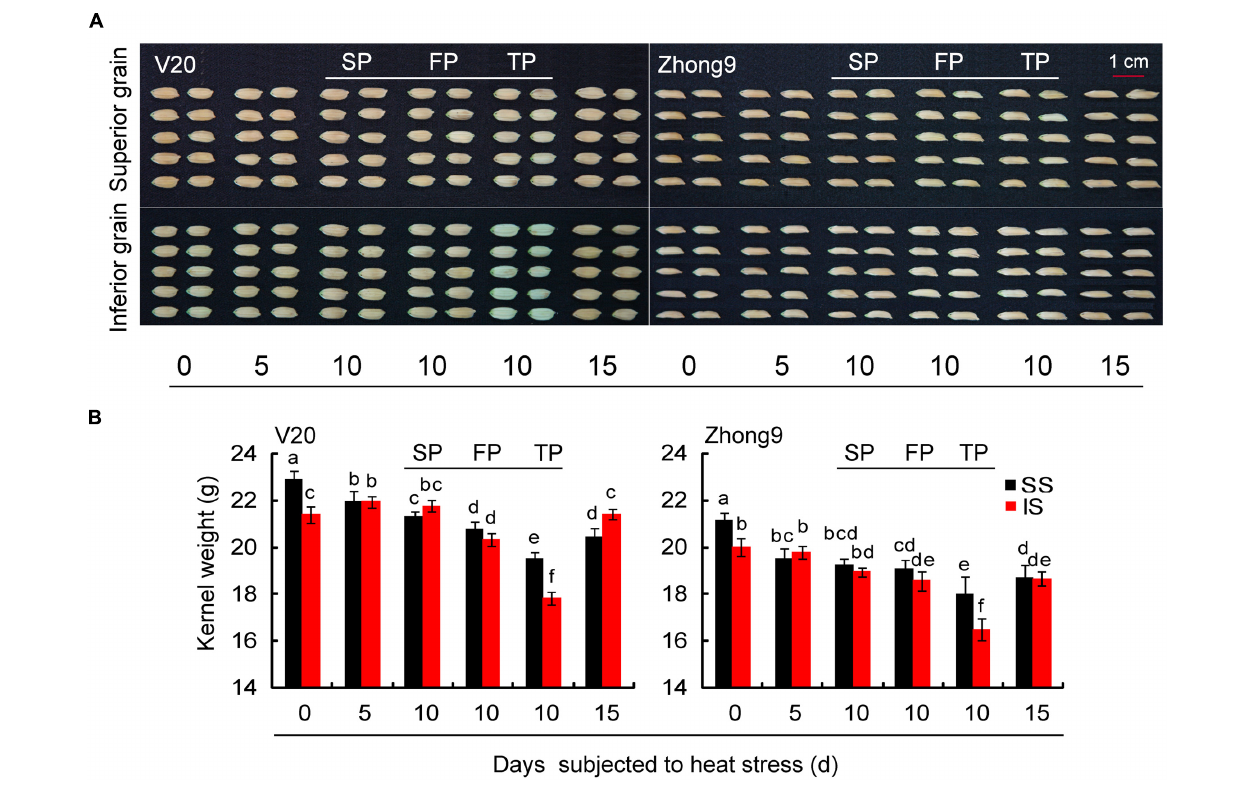
FIGURE 3 | Effect of heat stress on the kernel weight of superior and inferior spikelets of rice at anthesis. These rice plants were subjected to heat stress of 40 ◦ C for 5, 10, and 15 days after flowering, and determined at maturity. (A) The pictures of the superior and inferior grains in both genotypes under control and heat stress. (B) The mean data of kernel weight of superior and inferior grains in both genotypes under control and heat stress. SS and IS were indicated as superior spikelets and inferior spikelets, respectively. 0 day was indicated as control that rice plants without heats stress imposed. SP were controlled in each rice plants except for the treatments of FP and TP. SP, FP, and TP present each rice plant possessing six panicles, four panicles, and two panicles, respectively. Vertical bars denote standard deviations ( n = 3). Different letters indicate significant differences between the superior spikelets and inferior spikelets in the same cultivar ( P <